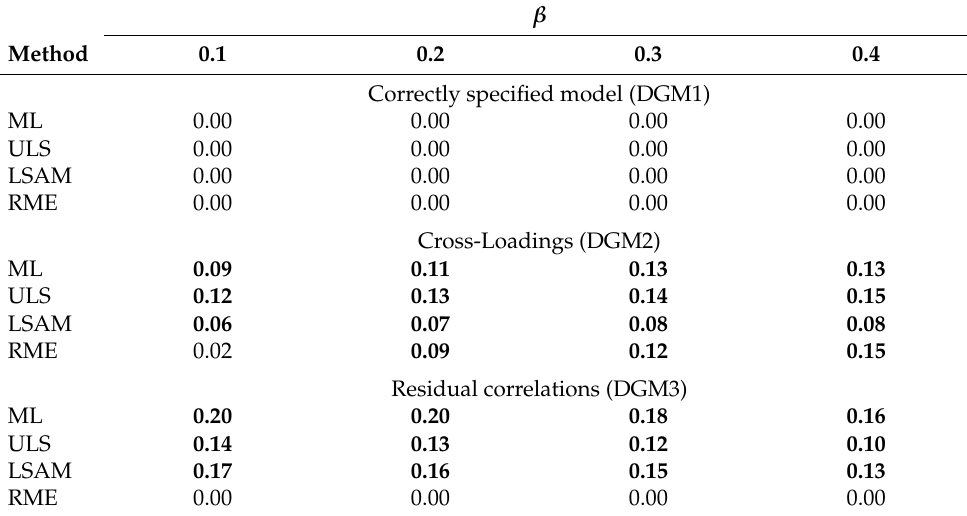
Table 9. Focused Simulation Study 4A (five factors): Average absolute bias of estimated factor correlation as a function of the common regression parameter β and the three data-generating models DGM1, DGM2, and DGM3 at the population level β Method 0.1 0.2 0.3 0.4 Correctly specified model (DGM1) ML 0.00 0.00 0.00 0.00 ULS 0.00 0.00 0.00 0.00 LSAM 0.00 0.00 0.00